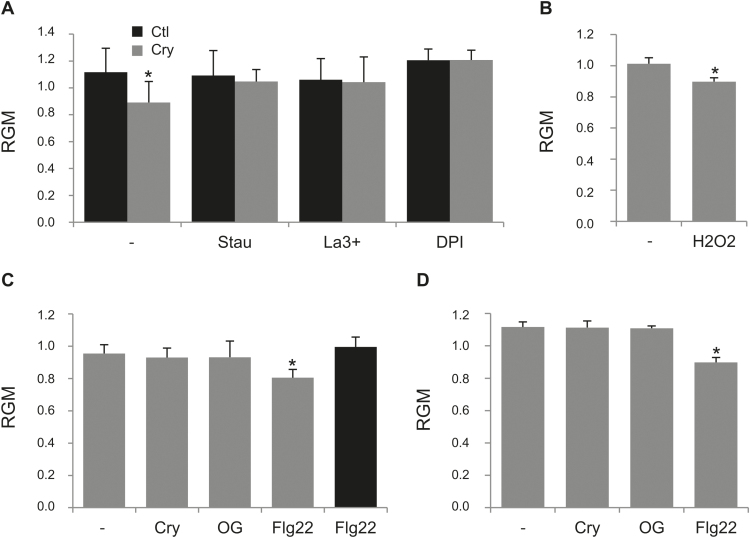
Elicitor-induced increase of PM order depends on ROS production. (A) Effect of signalling inhibitors (staurosporin, Stau, 2.5mM; lanthanum, La3+, 50 µM; diphenyleneiodonium, DPI, 5 µM; none, –) on RGM of di-4-ANEPPDHQ-labelled tobacco BY-2 cells without elicitor treatment (Ctl, black histograms) or after a 5min cryptogein elicitation (Cry, 50nM, grey histograms). (B) Effect of H2O2 addition (100 µM) on RGM of di-4-ANEPPDHQ-labelled tobacco BY-2 cells. (C) Effect of the NADPH oxidase activity inhibitor DPI (5 µM, grey histograms, or 20 µM, black histogram) on RGM of di-4-ANEPPDHQ-labelled tobacco BY-2 cells treated with different elicitors (–, none; Cry, 50nM; OG, 50ng ml−1; or Flg22, 20nM). (D) Effect of elicitors (–, none; Cry, 50nM; OG, 50ng ml−1; or Flg22, 20nM) on RGM of di-4-ANEPPDHQ-labelled tobacco gp3 cells. Mean values ±SEM (n>4 independent experiments). Asterisks indicate a significant difference (P-value <0.05).